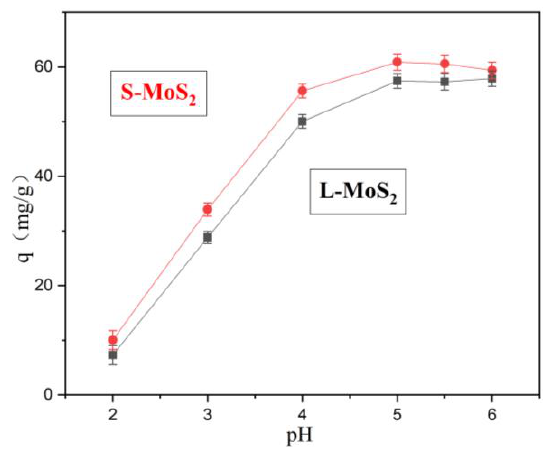
Figure 4. Cu 2+ adsorption onto MoS 2 with two morphologies at different pH values (C 0 : 60 mg/L, Time: 8 h, 25 °C).